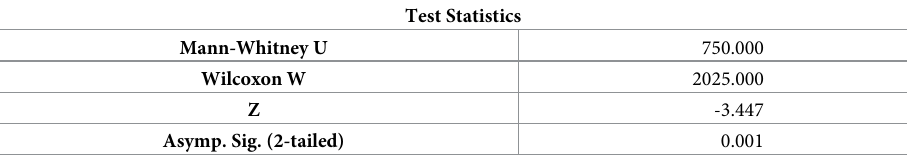
Table 8. Non-parametric Mann Whitney U test for the CSTHTS problem.